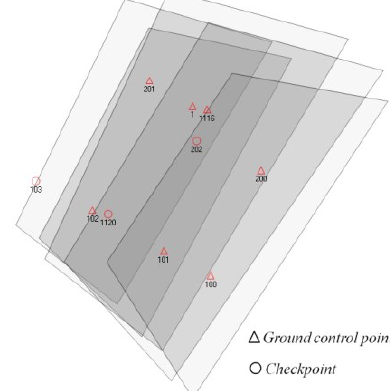
Figure 6. Configuration of the photogrammetric project with the images, GCP and check